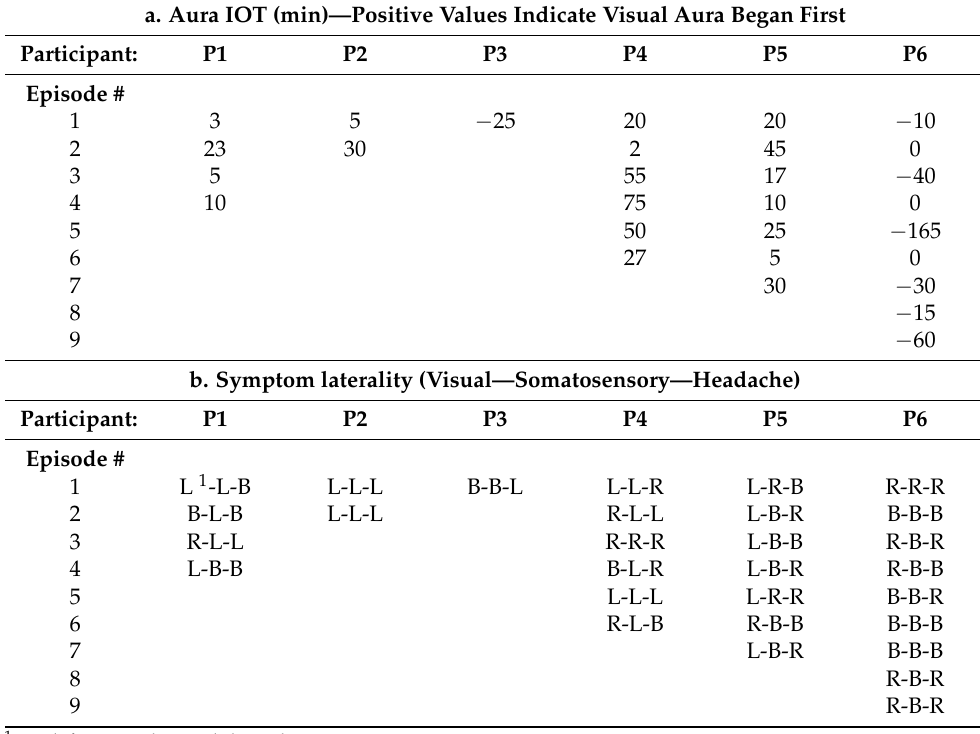
Table 2. Initiation offset times (IOT) in minutes and laterality information about auras and